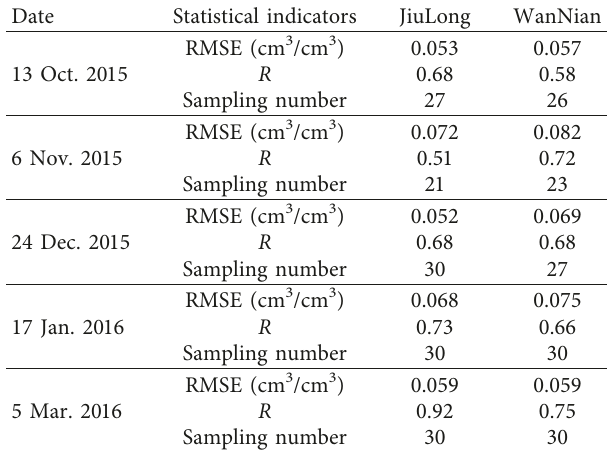
Figure 7: Comparison between the measured and estimated soil moisture using the Alpha model. (a) Comparison between the estimated and measured soil moisture on 13 Oct. 2015. (b) Comparison between the estimated and measured soil moisture on 6 Nov. 2015. (c) Comparison between the estimated and measured soil moisture on 24 Dec. 2015. (d) Comparison between the estimated and measured soil moisture on 17 Jan. 2016. (e) Comparison between the estimated and measured soil moisture on 5 Mar. Table 4: Quantitative evaluation of the estimated soil moisture using Alpha model.